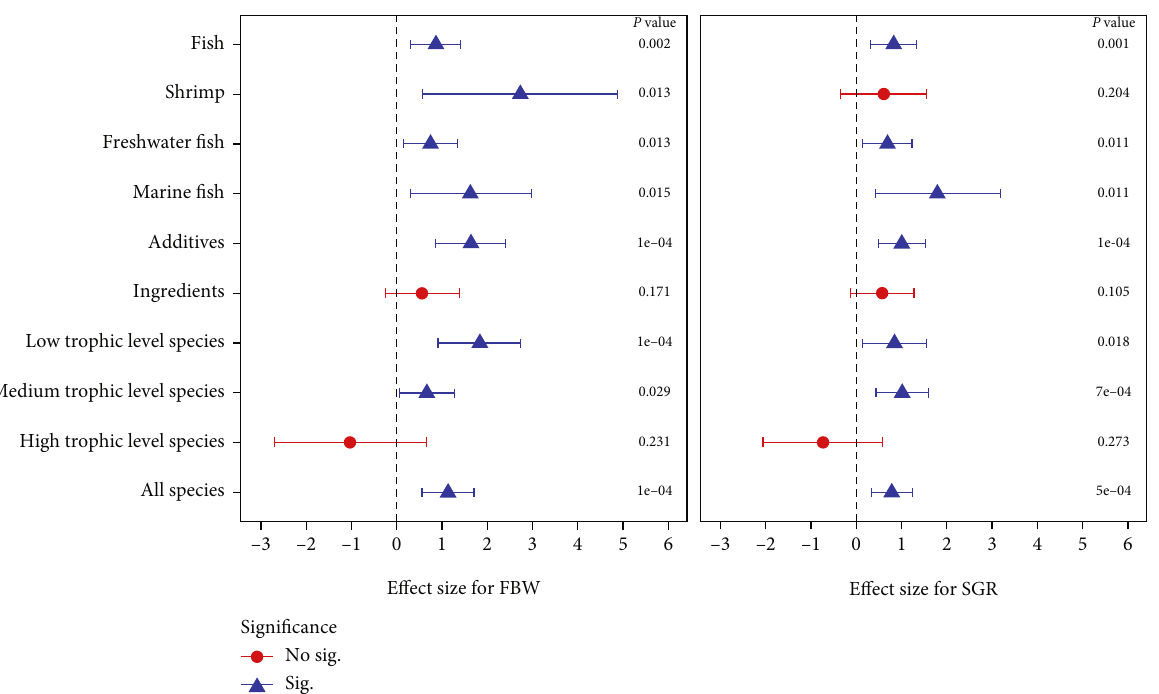
Figure 2: Hedges ’ g comparisons for FBW and SGR ( mean ± 95 % con fi dence interval) subgroup analysis (random-e ff ects model). The con fi dence interval intersecting with the dashed line indicated no signi fi cant di ff erences between the control group and treatment group, and vice